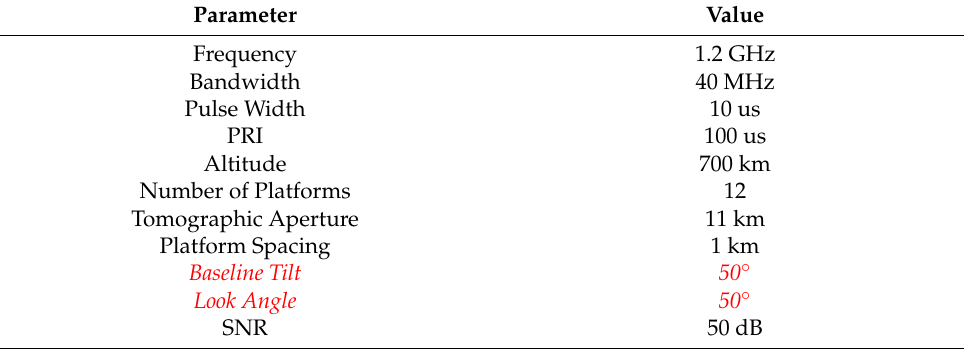
Table 9. Parameters used for Example